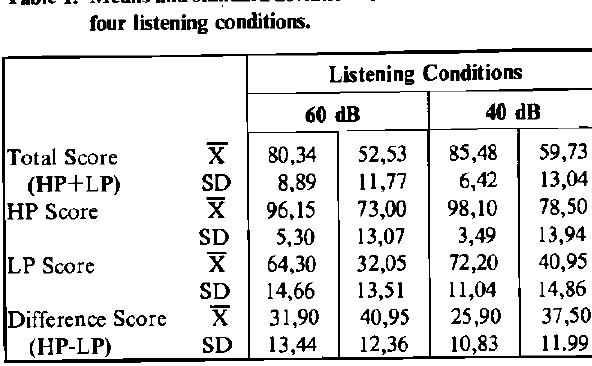
Table 1: Means and standard deviations of scores obtained under four listening conditions.